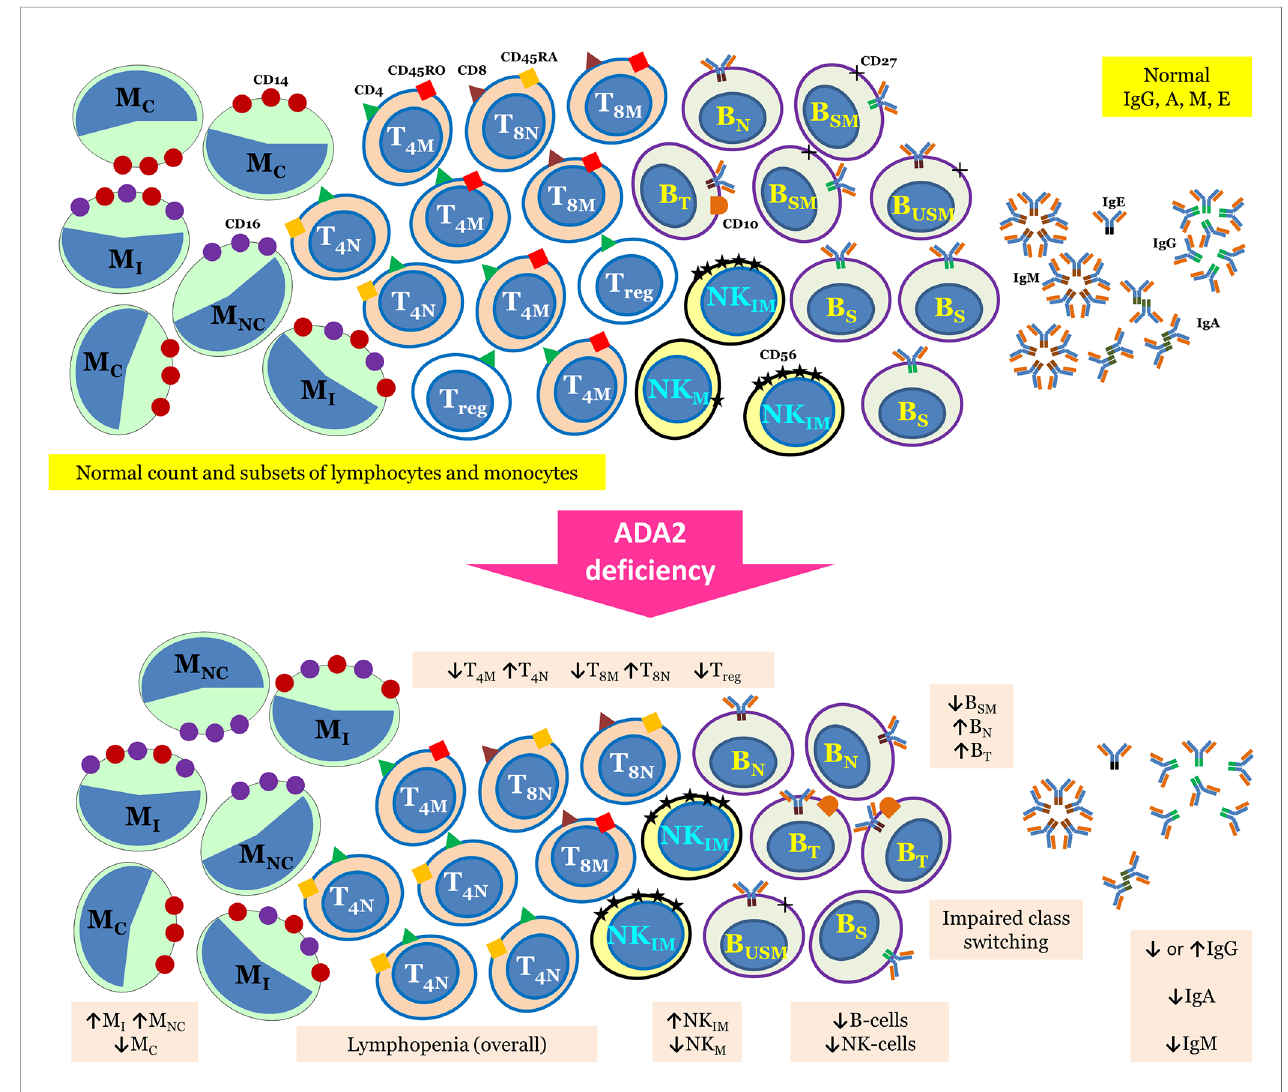
FIGURE 1 | Summary of immunological abnormalities in patients with